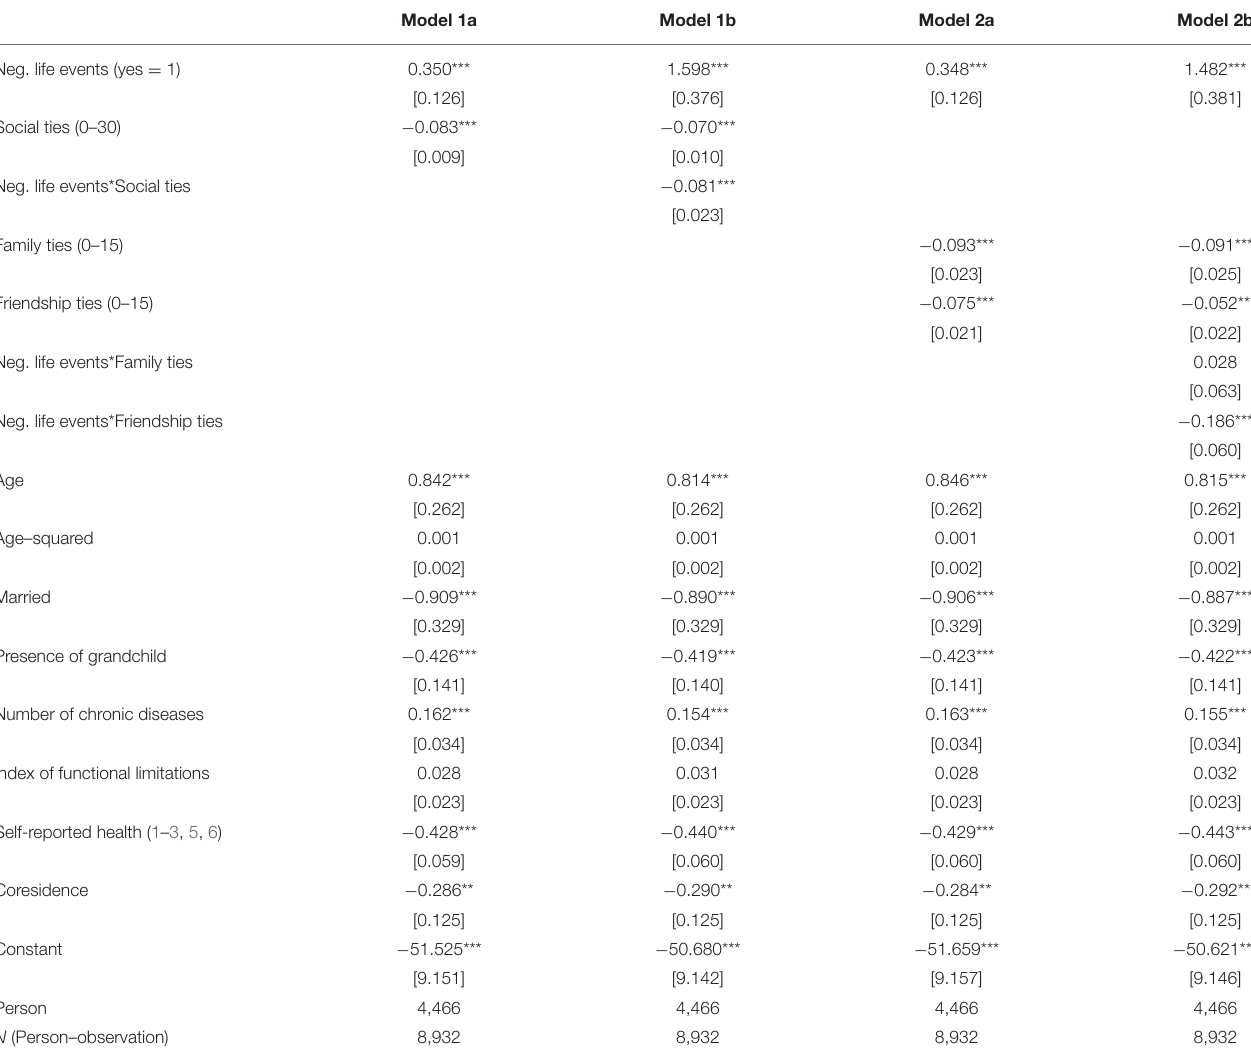
TABLE 2 | The fixed effect models predicting depressive symptoms of chinese older adults, total sample, CLASS 2016 and 2018, N =